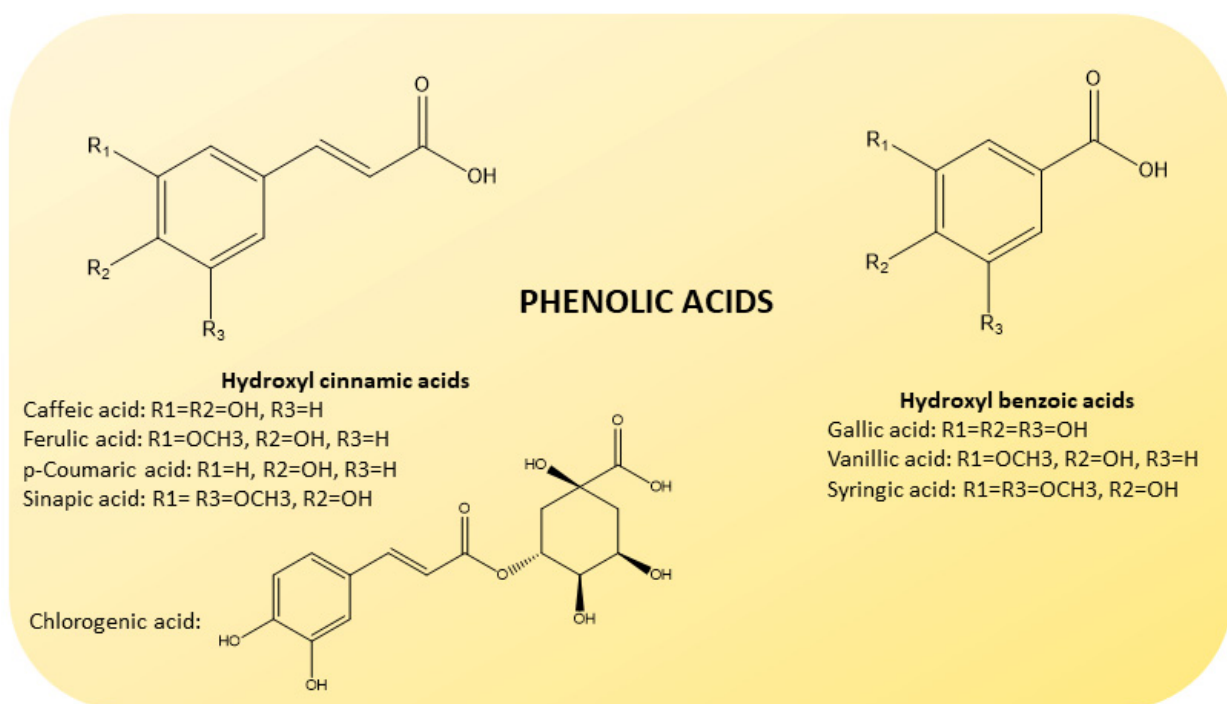
Figure 5. Chemical structure of phenolic acids present in CF juices. Based on their origin, they are divided into hydroxybenzoic (gallic, vanillic and syringic acids; on the right ) and hydroxycinnamic (caffeic, ferulic, p-coumaric, sinapic and chlorogenic acids; on the left ) acids.